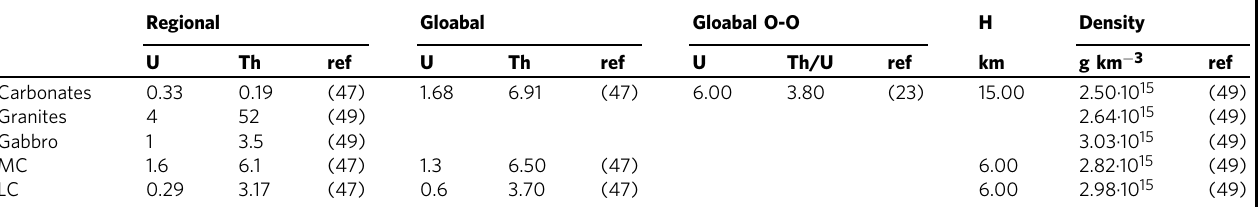
Table 1 Abundances of U and Th (in ppm), crust thickness and density used for calculations of 4 He